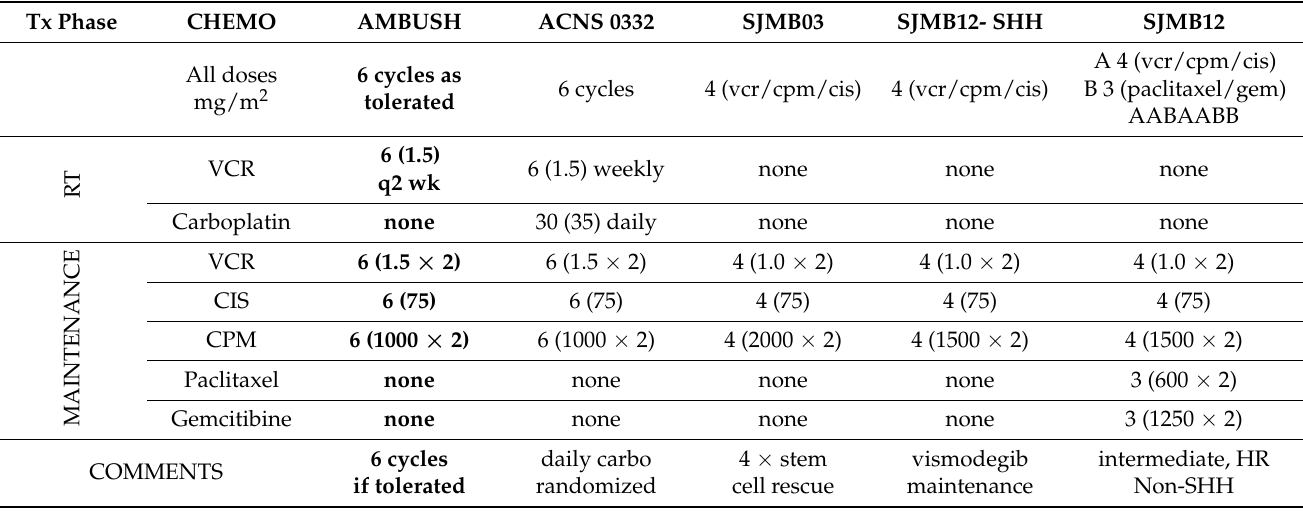
Table 2. Chemotherapy agents that are used in the treatment in high-risk risk MB with final AMBUSH regimen in comparison to other recently reported and ongoing